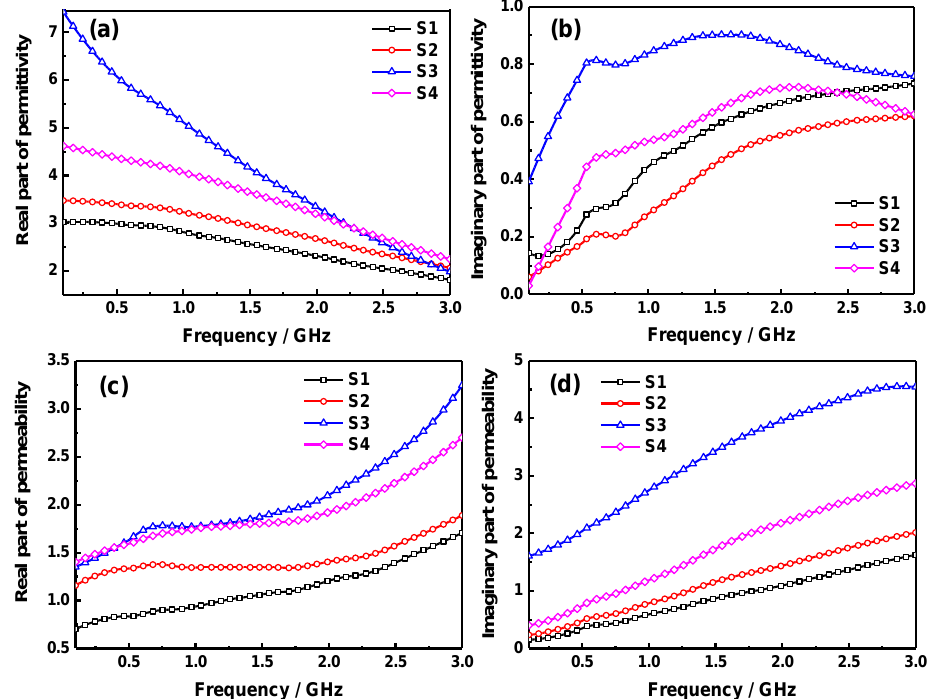
Figure 5. Frequency-dependent RL curves of S3 at different thicknesses.